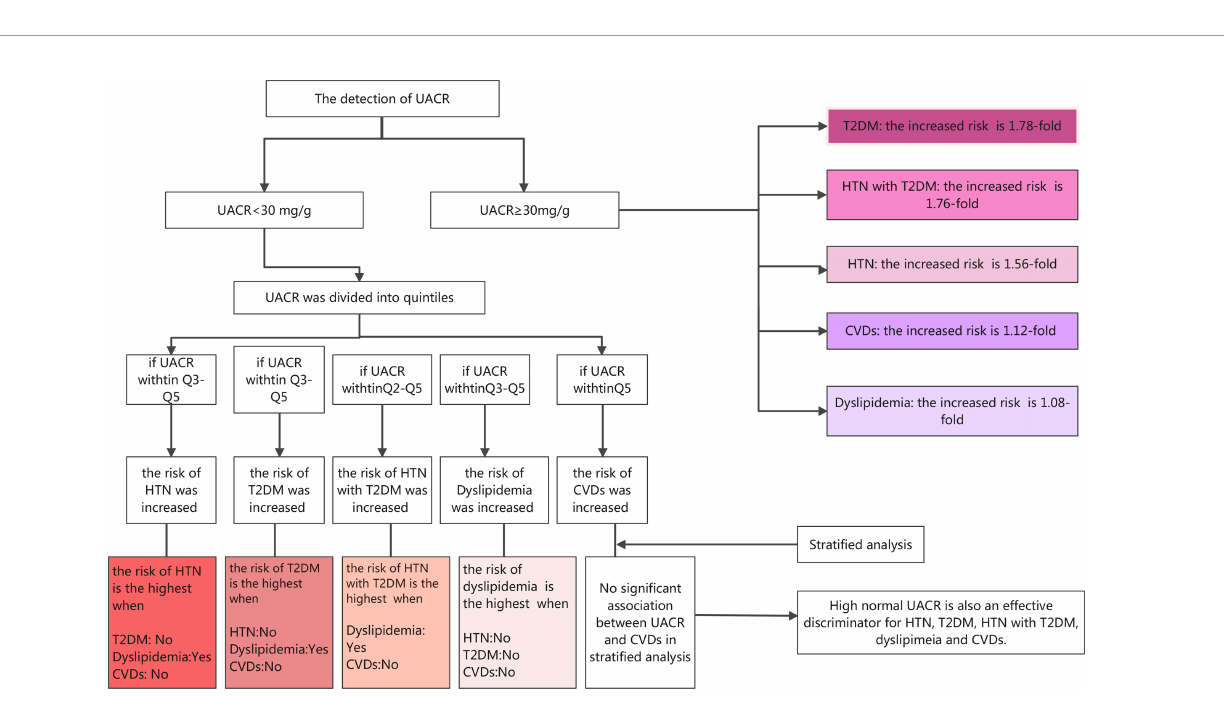
FIGURE 2 | The summary of the conclusion of this